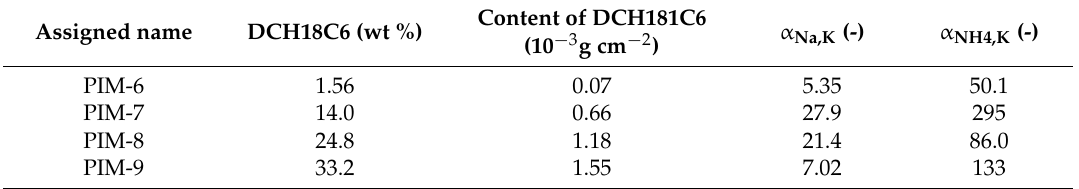
Table 4. Selectivity of K + over Na + and NH 4+ regarding the content of DCH18C6 in the PIM.